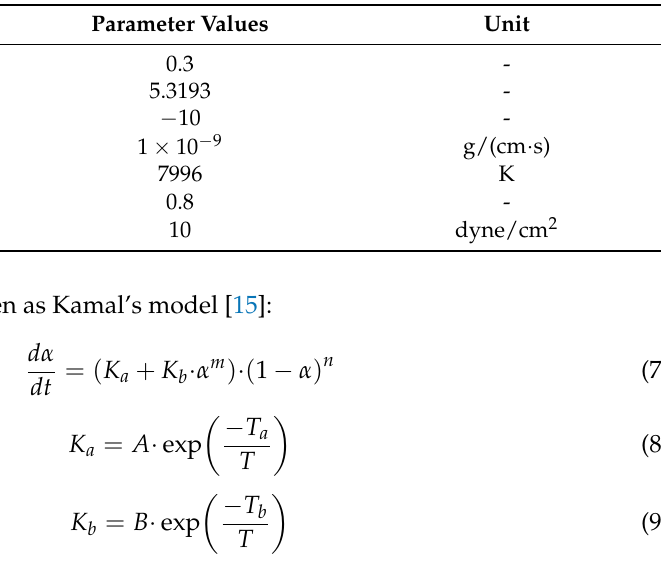
Table 1. Values of the Cross Castro–Macosko model constants. The constants were measured by a parallel-plate